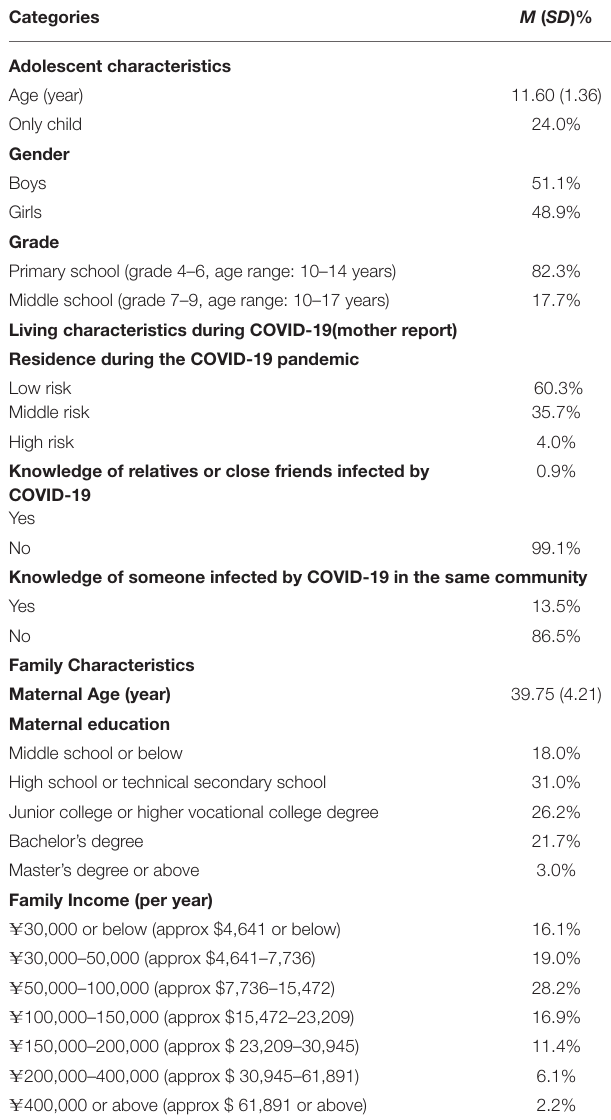
TABLE 1 | Demographic information of the sample ( N =